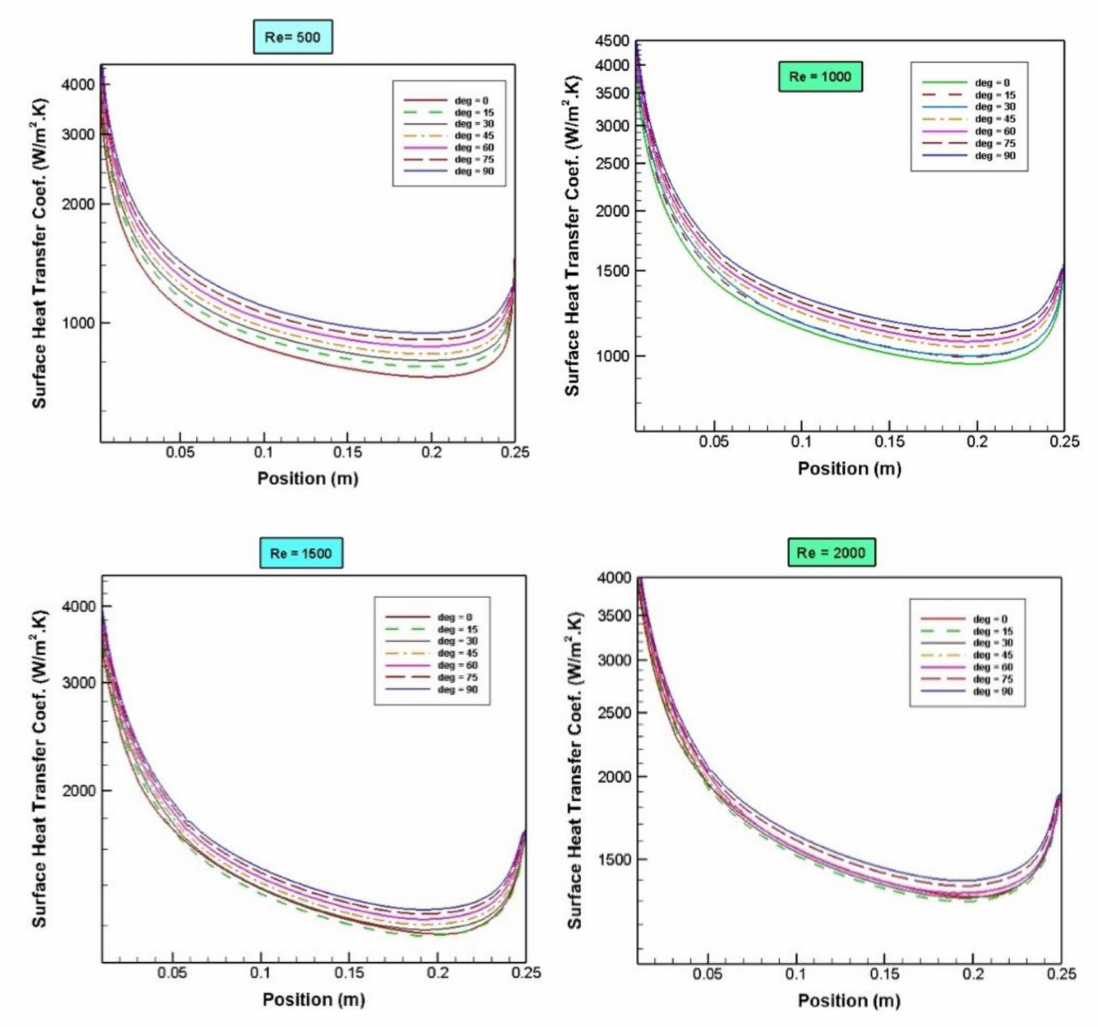
Figure 4. The variation of the surface HTC with the position at various Reynolds